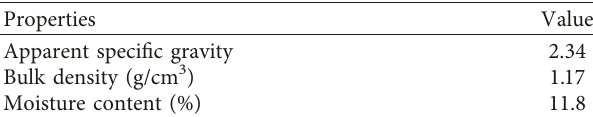
Figure 1: Strontium slag pile (a) and 2 μ m slag SEM image (b). Table 1: Physical properties of strontium